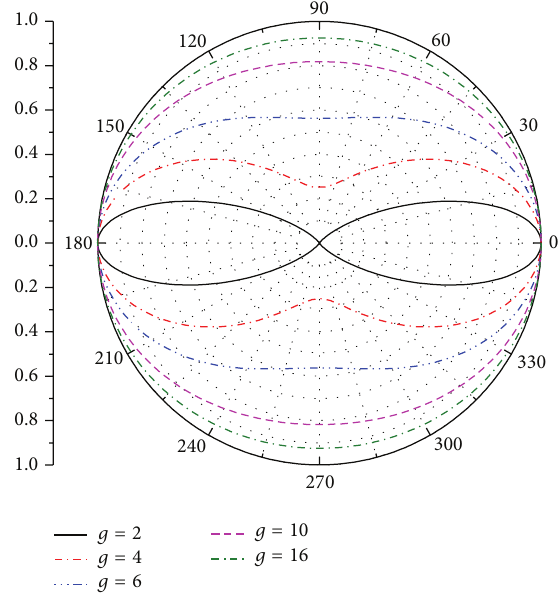
Figure 4: Formula calculated normalized radiation pattern on 𝑦 - 𝑧 plane against 𝑙 󸀠